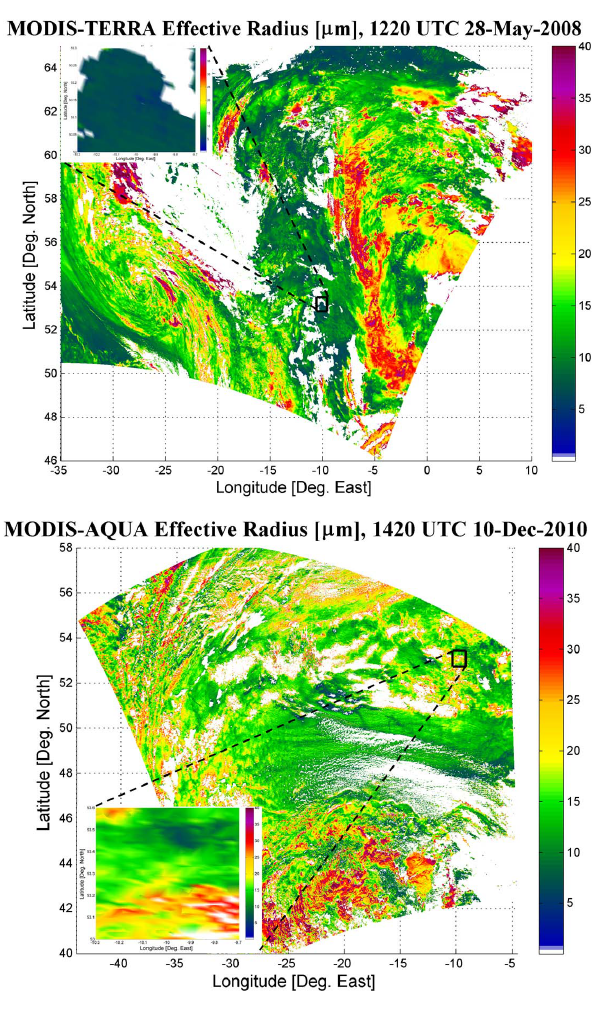
Fig. 8. MODIS-TERRA cloud effective radius from 12:20UTC overpass on 28 May 2008 (left) and MODIS-AQUA cloud effective radius from 14:20UTC overpass on 10 December 2010 (right). In enlarged frames are shown the 0.6 × 0.6deg box containing Mace Head Station (53.33 ◦ N, − 9.9 ◦